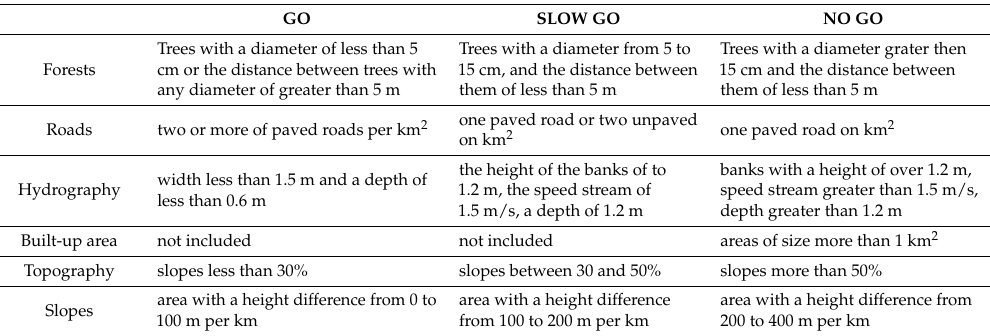
Table 4. Passability classes according to standardisation